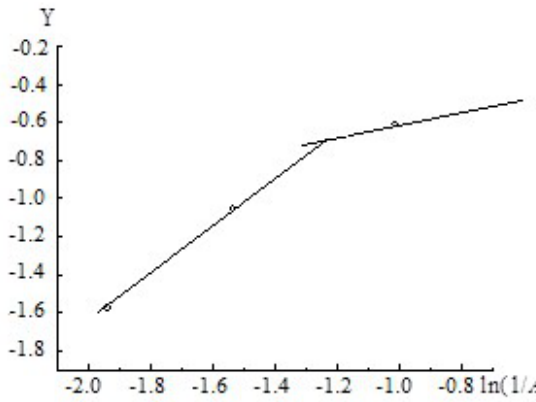
Figure 6. The adsorption isotherm for methanol vapors on the aluminum oxide material in the coordinates of the equation Y = ln ( θ − m )